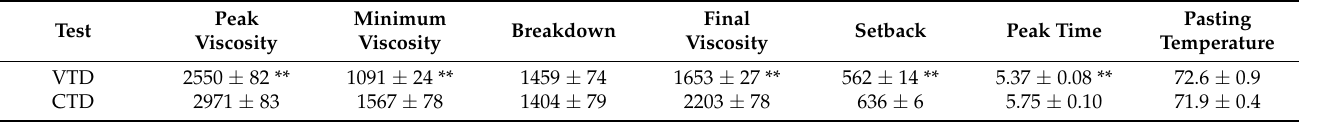
Table 7. Comparison of the RVA profiles.